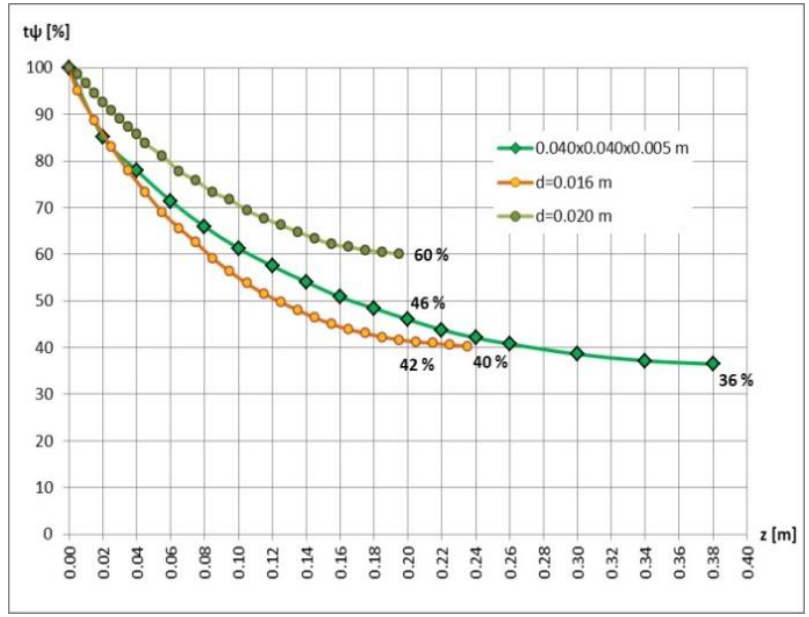
Figure 12. The comparative, relative t ψ [ % ] thermal distribution laws for α g = 0 ◦ and t O , n = 100 ◦ C.